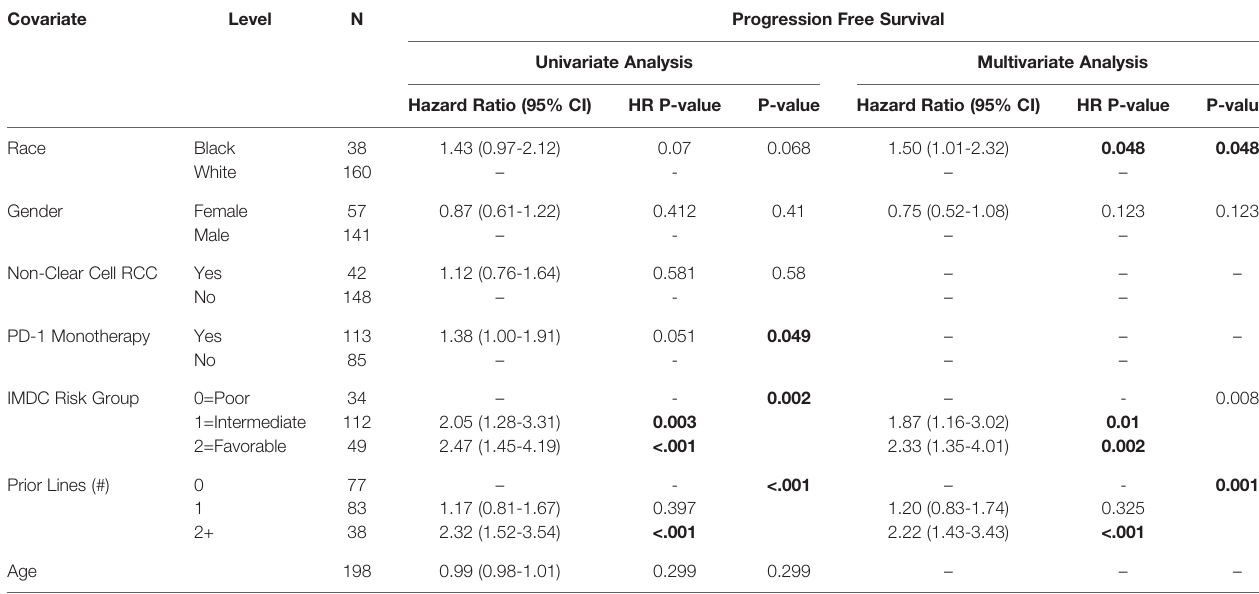
*The p-value is calculated by ANOVA for numerical covariates; and chi-square test or Fisher ’ s exact for categorical covariates, where appropriate. IO,Immunotherapy;PD-L1,Programmeddeath-ligand1;RCC,renalcellcarcinoma;CC,clearcell;NCC,non-clearcell;IMDC,InternationalMetastaticRCCDatabaseConsortium;ECOG PS, Eastern Cooperative Oncology Groups Performance Status. Bold denotes statistical signi fi